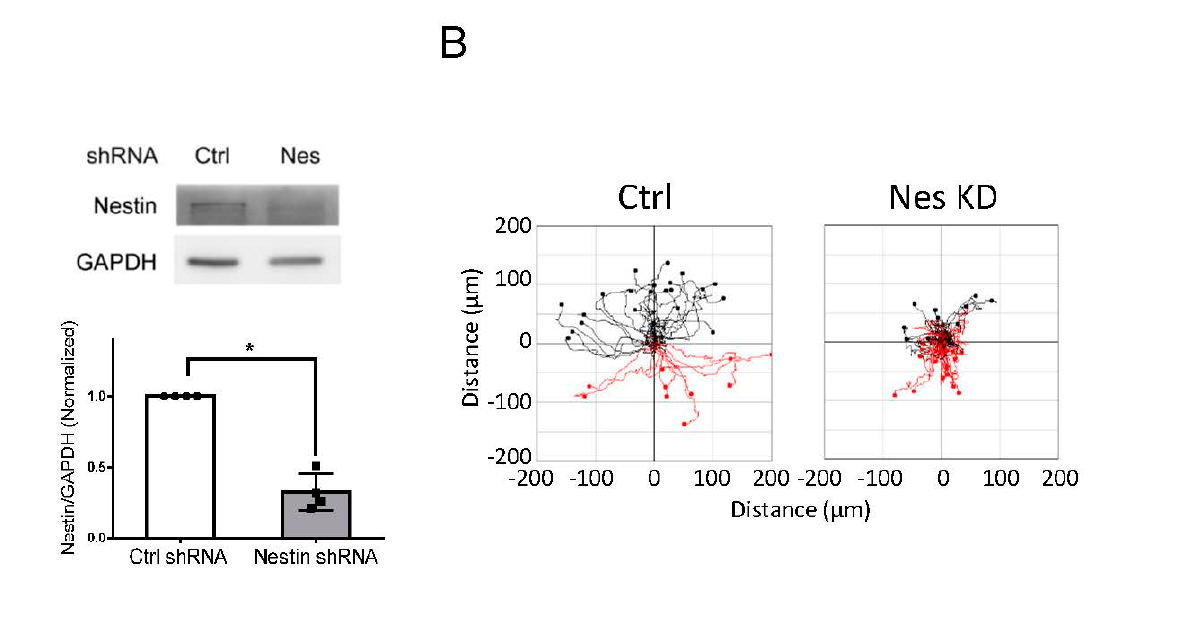
Figure 1. Knockdown (KD) of nestin reduces human ASM cell migration. ( A ) Protein expression of human ASM cells stably expressing control (Ctrl) shRNA or nestin shRNA was evaluated by im- munoblotting. Data are mean values of experiments from 4 batches of cell culture. Error bars indi- cate SE. ( B ) Cell migration was tracked using a time-lapse microscope. Images were taken every 10